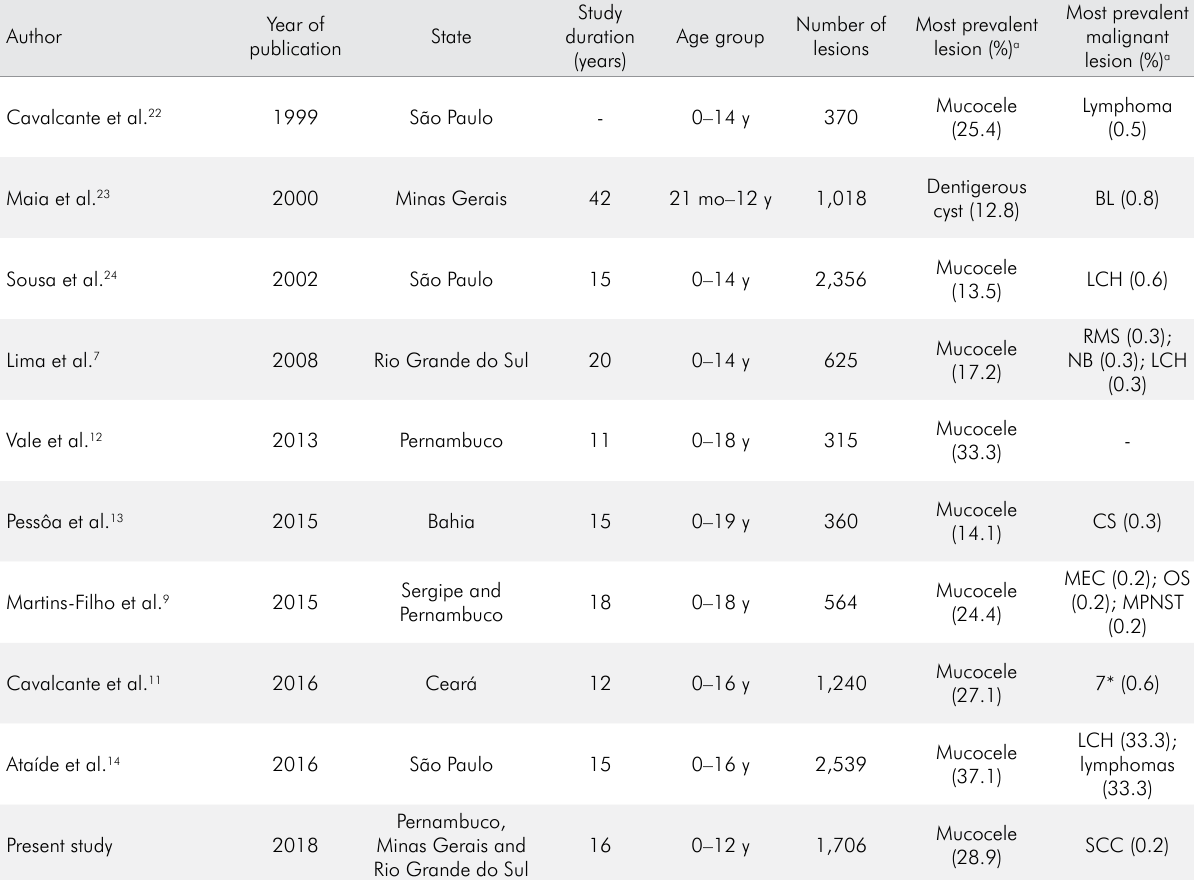
Table 3. Brazilian studies of oral and maxillofacial pathology in pediatric